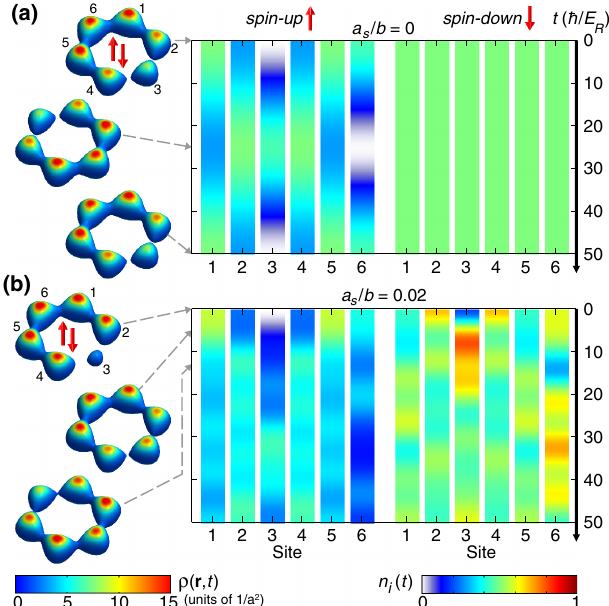
FIG. 4. Correlated dynamics after particle removal. (a) Quantum revival for the noninteracting system and (b) dynamics in the =b ¼ 0 . 02 and antiferromagnetically correlated state for a s V 0 ¼ 6 E . The plots display the occupation number of the R Wannier state at site i of the ring for spin-up (left) and spin- down (right) as a function of time t . The images on the left depict the summed density of both spin states. The three-dimensional isosurface is plotted for 6 =a 2 b , where the coloring refers to the two-dimensional